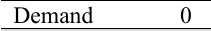
Distribution of demand Distribution of lead